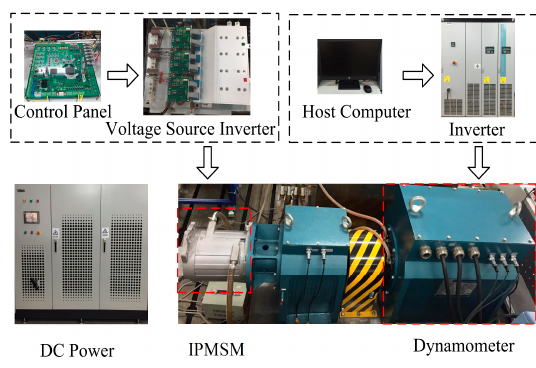
Figure 8. Experimental platform.